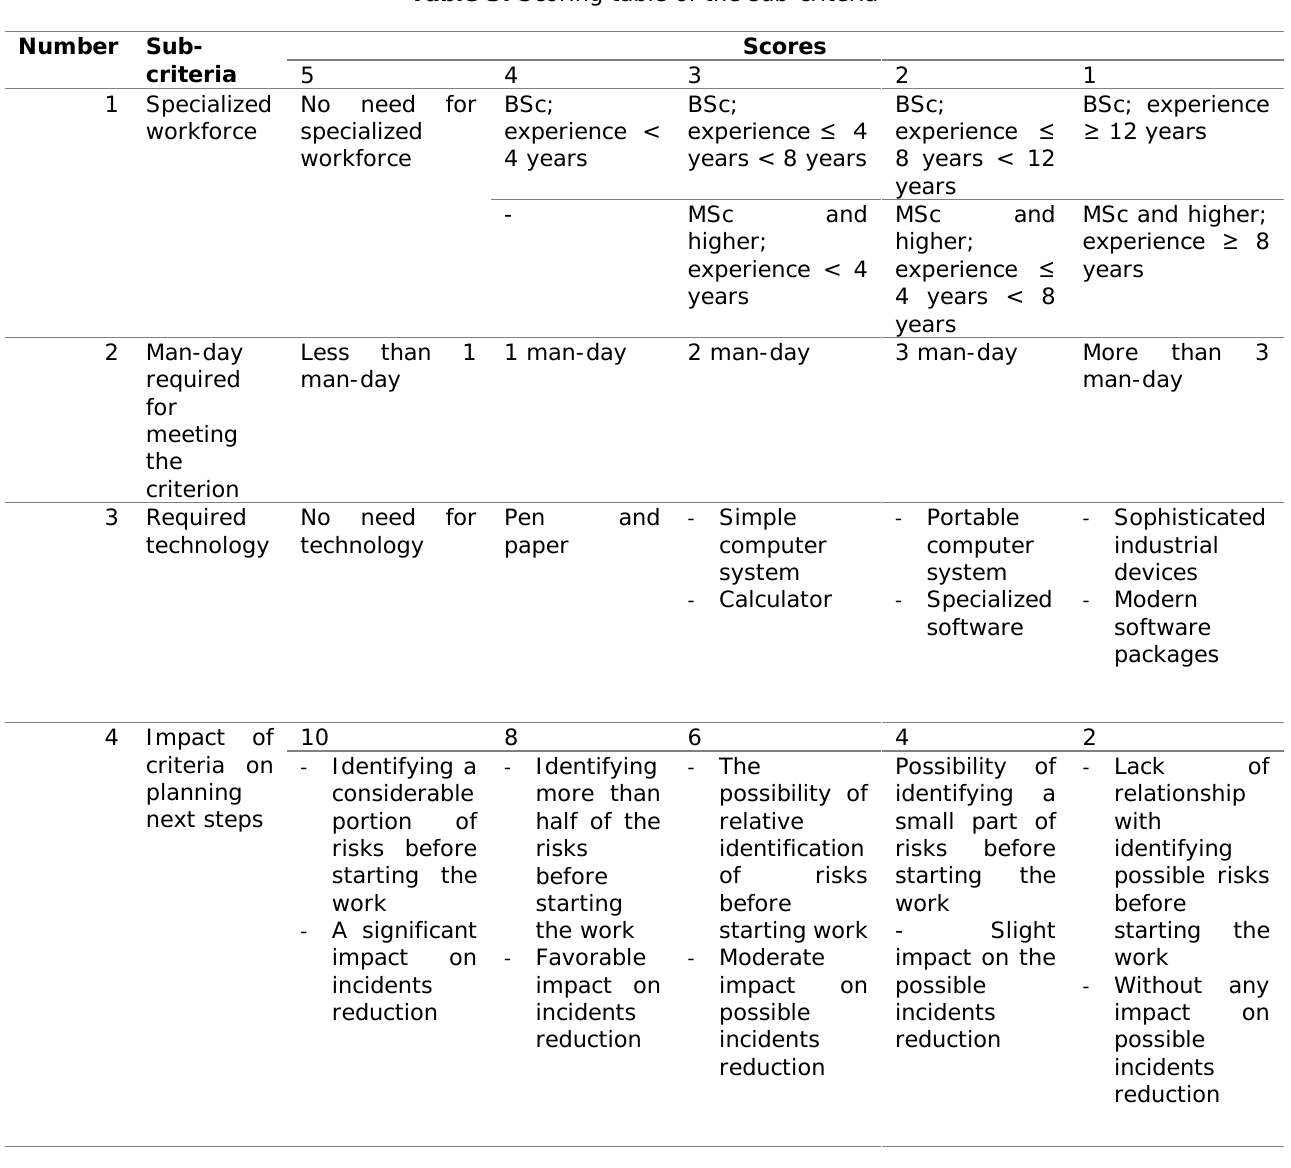
Table 3. Scoring table of the